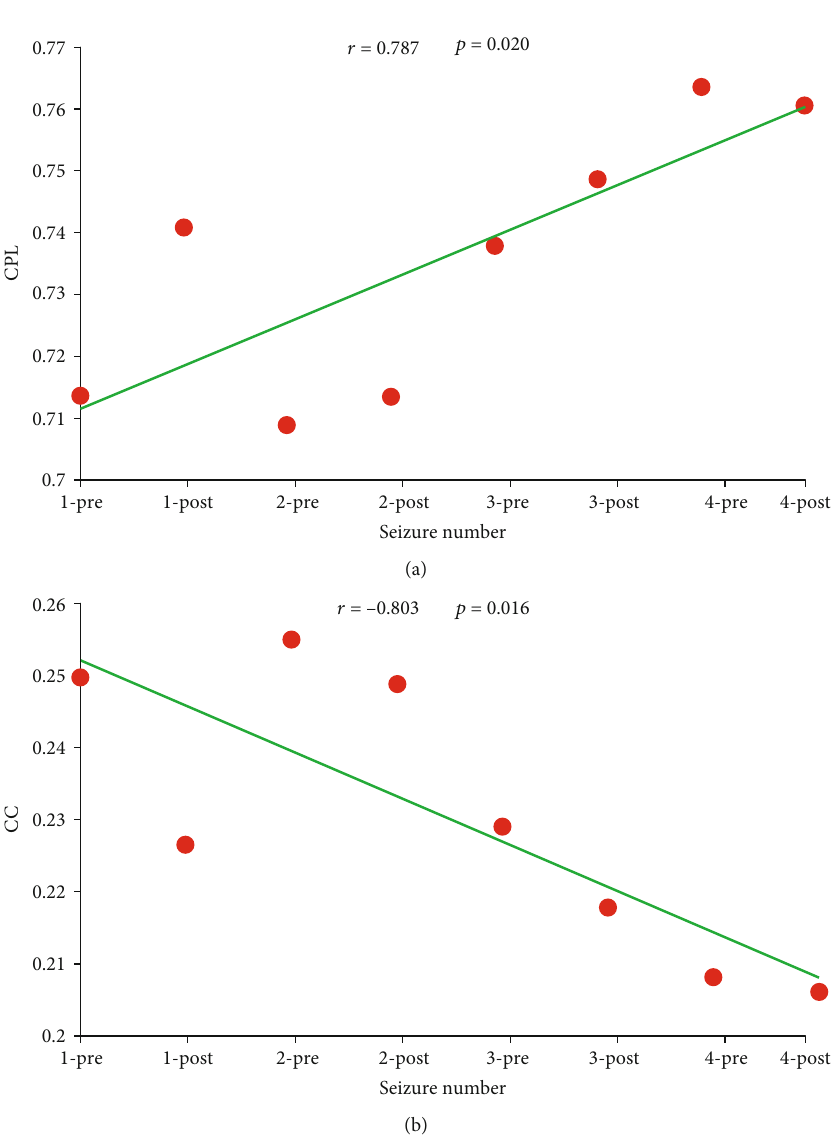
Figure 4: Potential relationships between network metrics and seizure number in the delta band. (a, b) The green solid line indicates the regression of network properties (CPL and CC) relative to the seizure